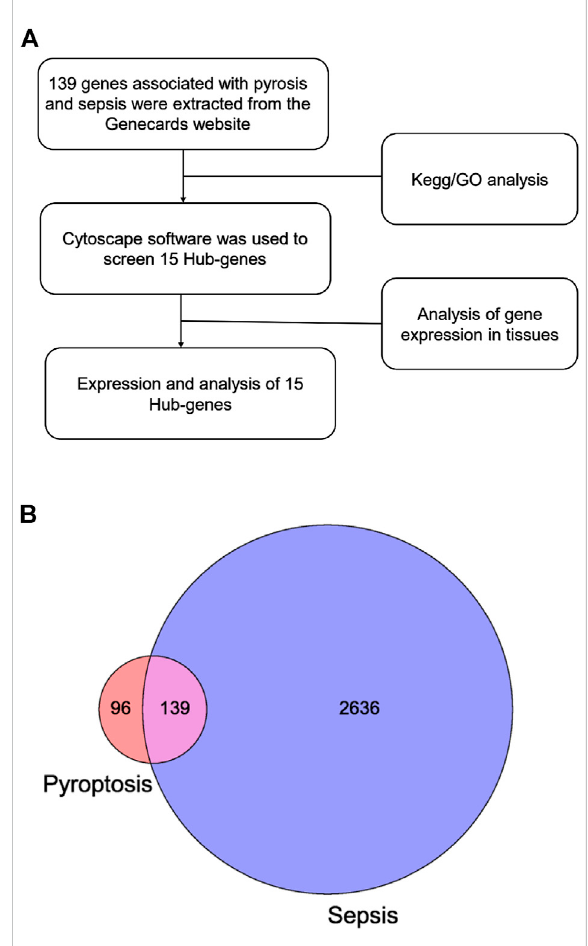
FIGURE 2 Strategyandresultsofbioinformaticanalysis. (A) Flowchartof gene screening. (B) The Venn diagram shows the intersection between pyroptosis and sepsis